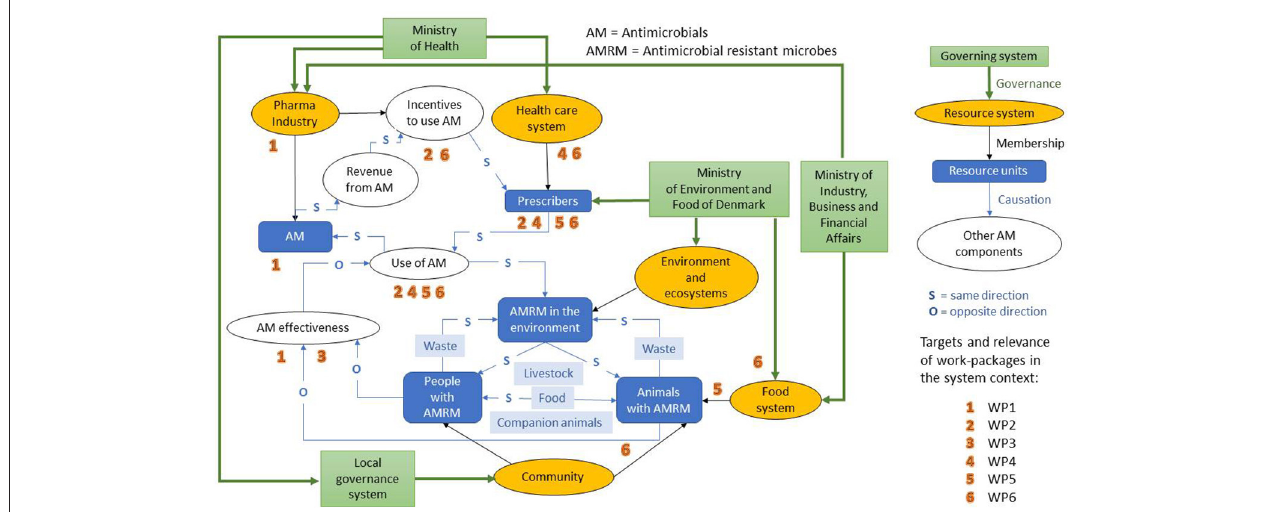
FIGURE 1 | Visual representation of the context of AMR within Denmark relative to the UC-CARE research project, and an illustration of where UC-CARE work packages belong in the system. Work packages are described in the main manuscript text [Source: Modified from Rüegg et al. (26)].